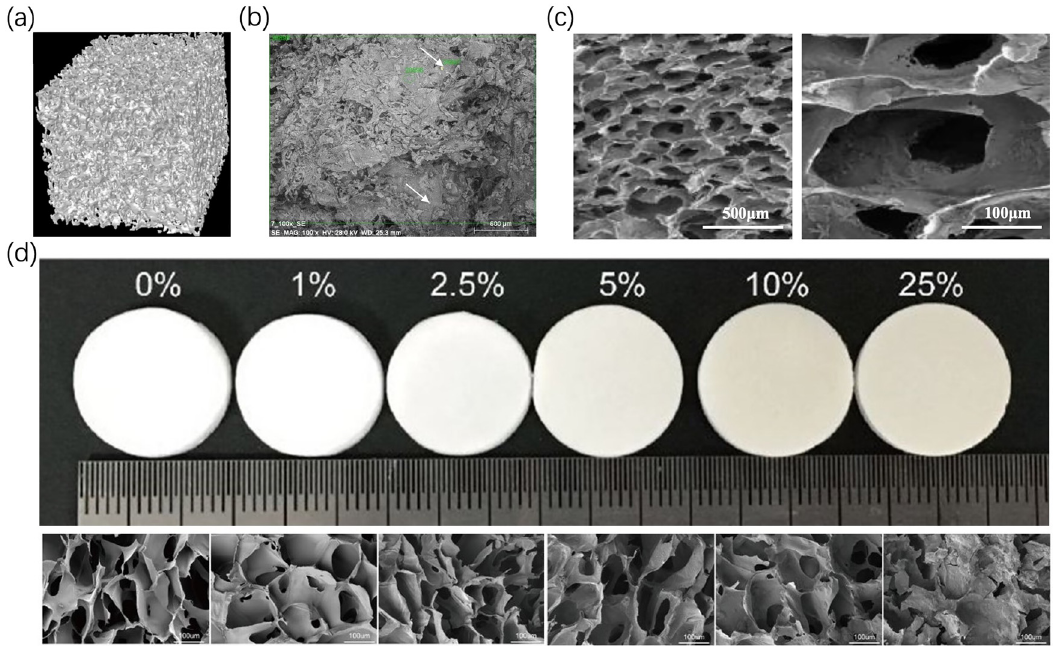
Figure 5: Various HA - based sca ff olds can be constructed through freeze drying. ( a ) The 3D reconstruction image of GHA polymeric sca ff olds [ 86 ] . ( b ) The SEM images of chitosan/collagen/HA sca ff olds with precipitated calcium phosphate [ 87 ] . ( c ) The SEM images of HA/chon - droitin sulfate/chitosan/nano hydroxyapatite hybrid sca ff old [ 88 ] . ( d ) The photograph of nano - pearl powder/chitosan/HA sca ff olds with di ff erent proportions of nano - pearl powder [ 89 ]